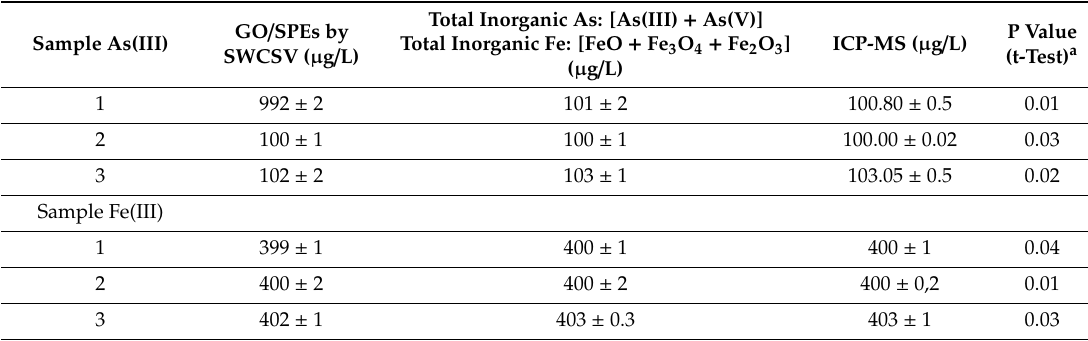
Table 3. Comparative study between GO / SPE and ICP-MS for As(III) and Fe(III) quantification. Sample